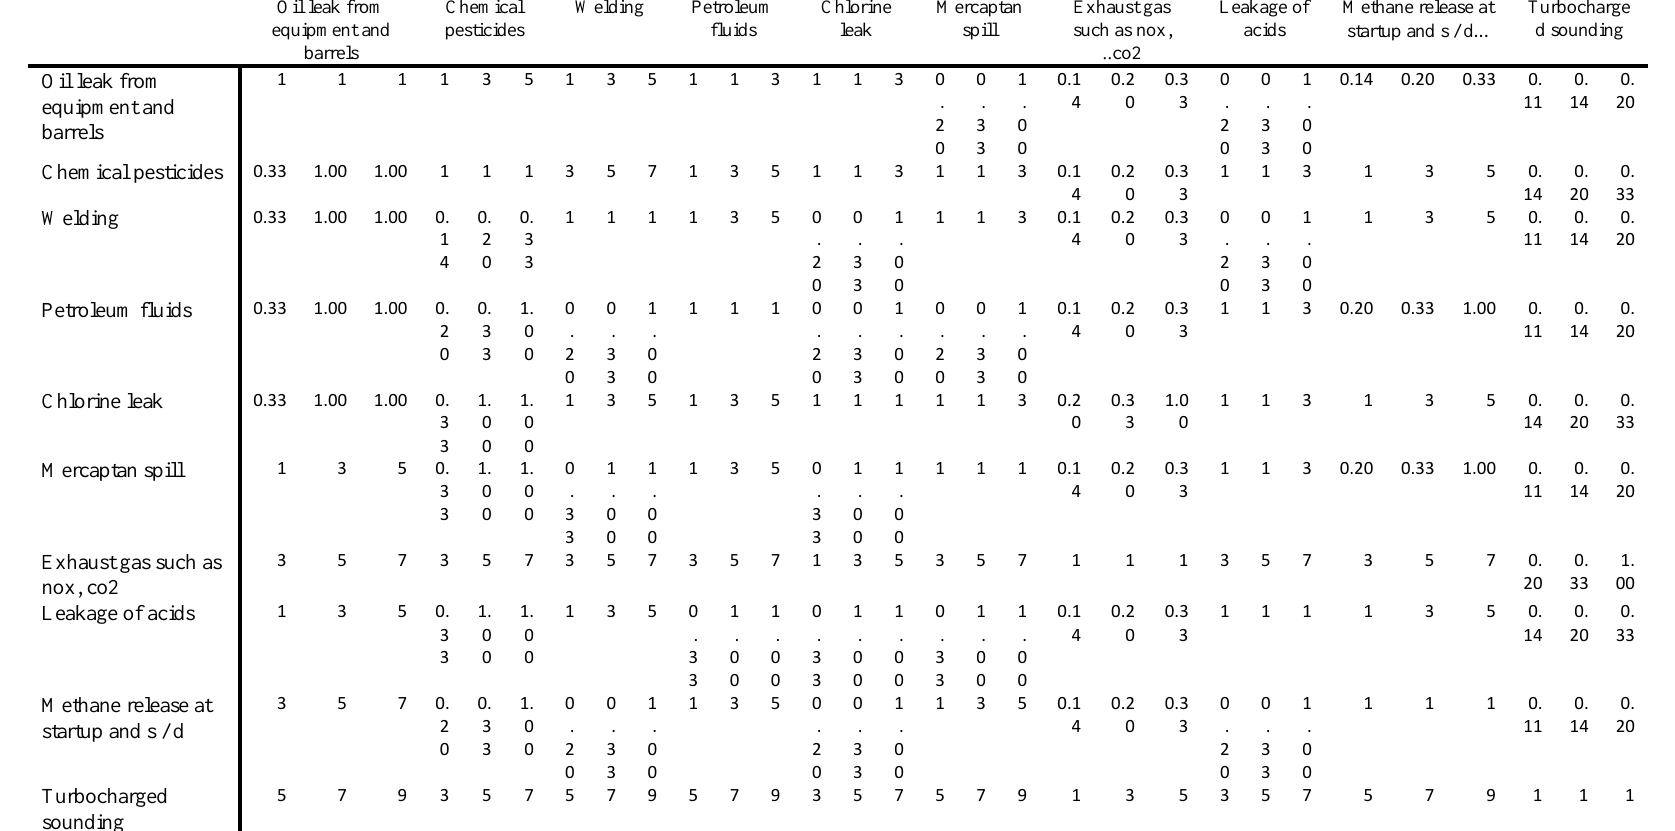
Tables 9. Calculate the compliance coefficient under the environmental